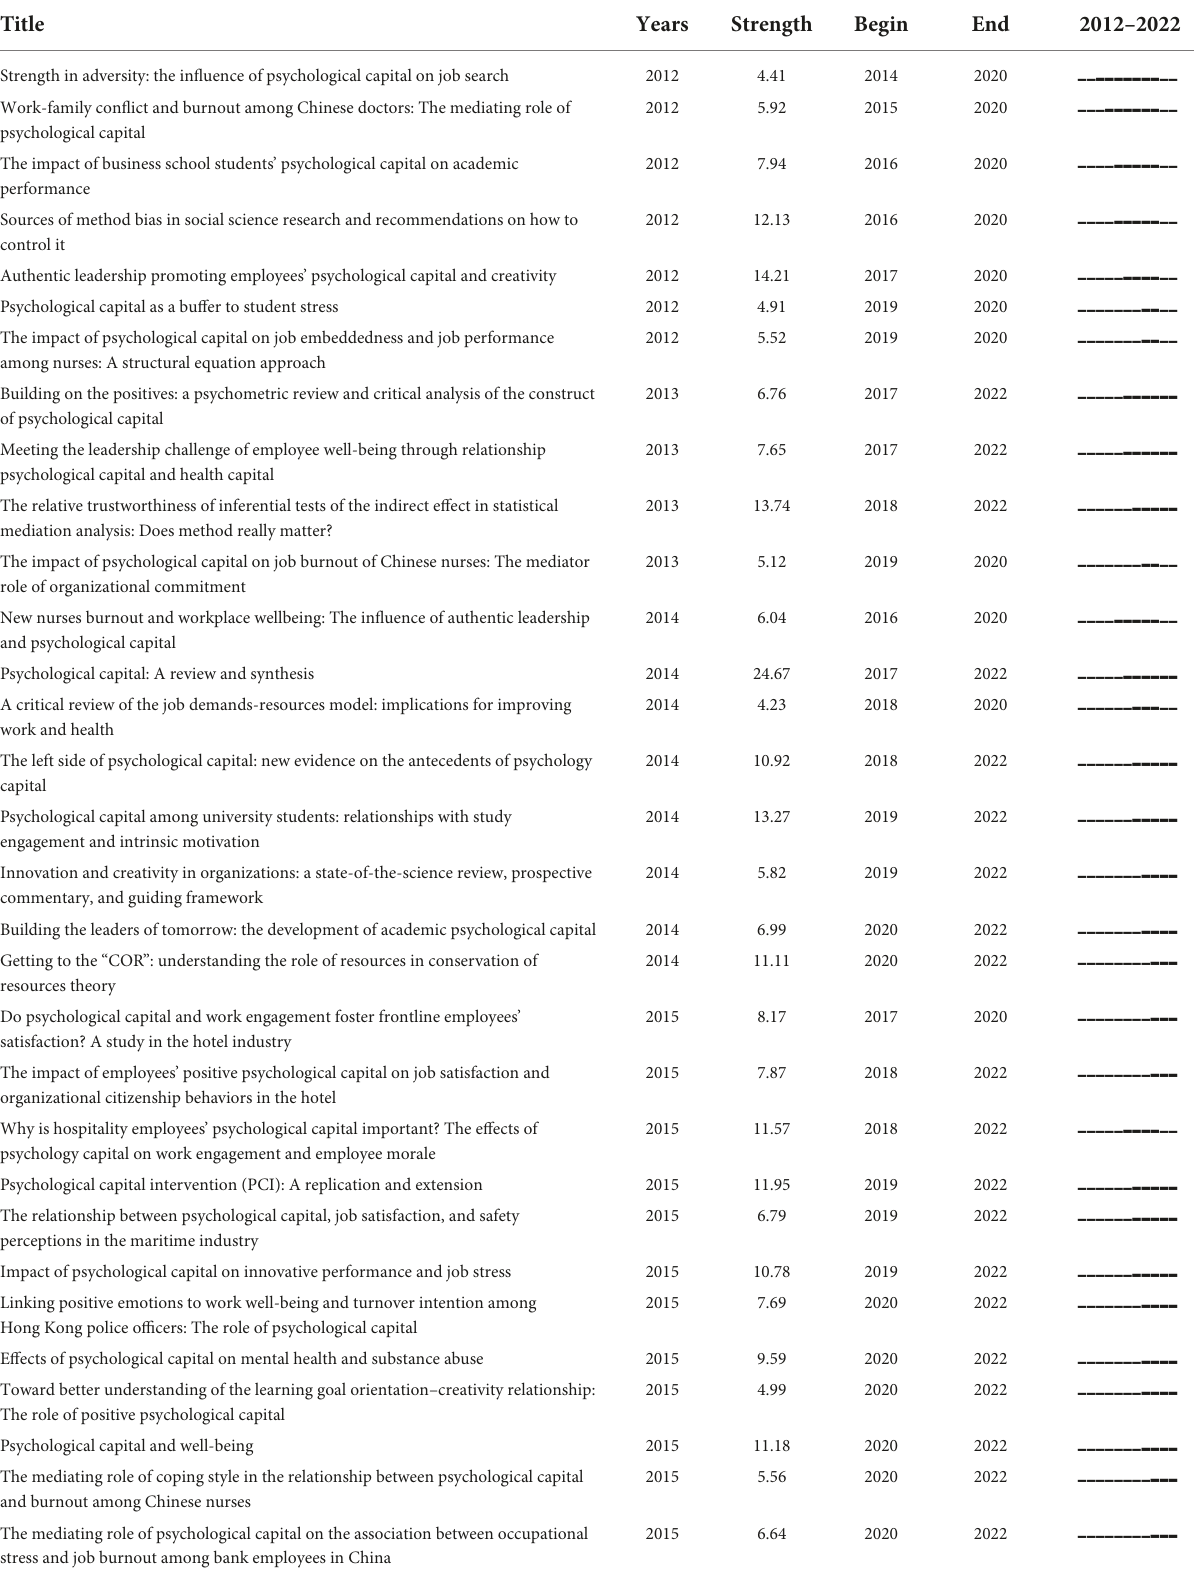
TABLE 6 45 References with strongest citation bursts